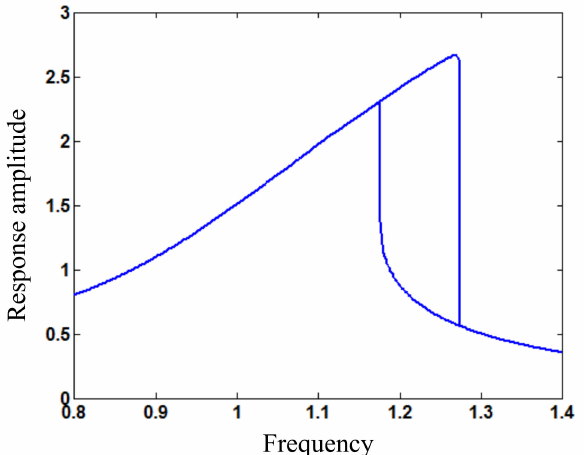
Figure 3. Amplitude ( w Am ) frequency ( ω ) relation around principal resonance for loading amplitude F s 1 = 0.34.